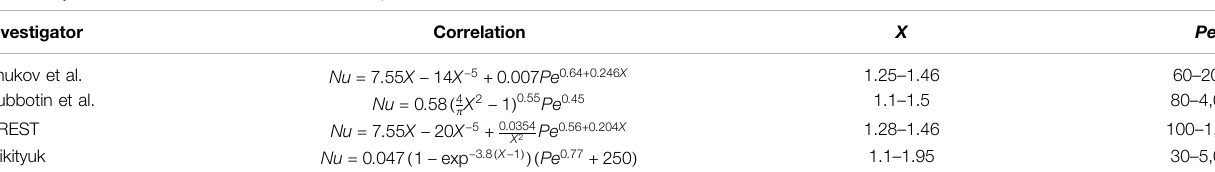
Frontiers in Energy Research |